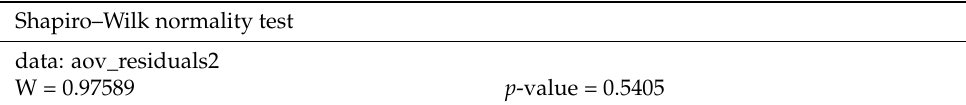
Table 10. Shapiro–Wilk test for flexure strength for DETAX material.